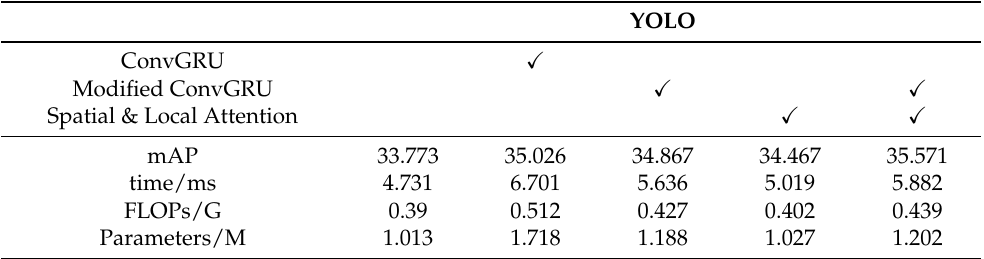
Table 2. Ablation